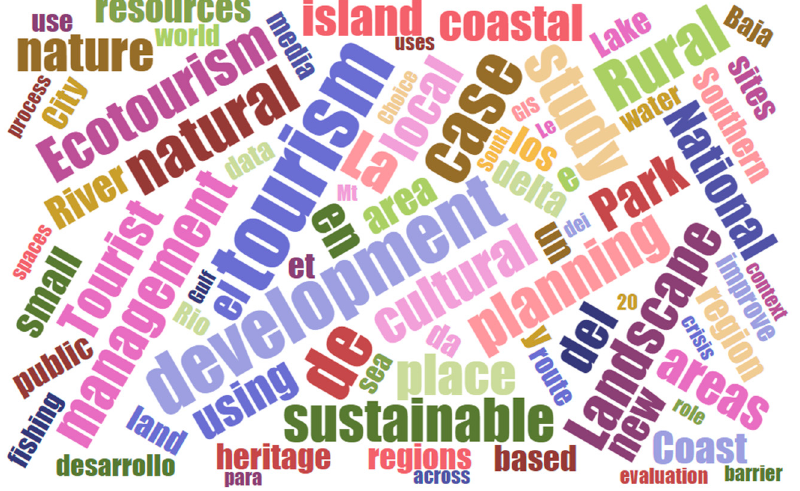
Figure 4. Titles word cloud.